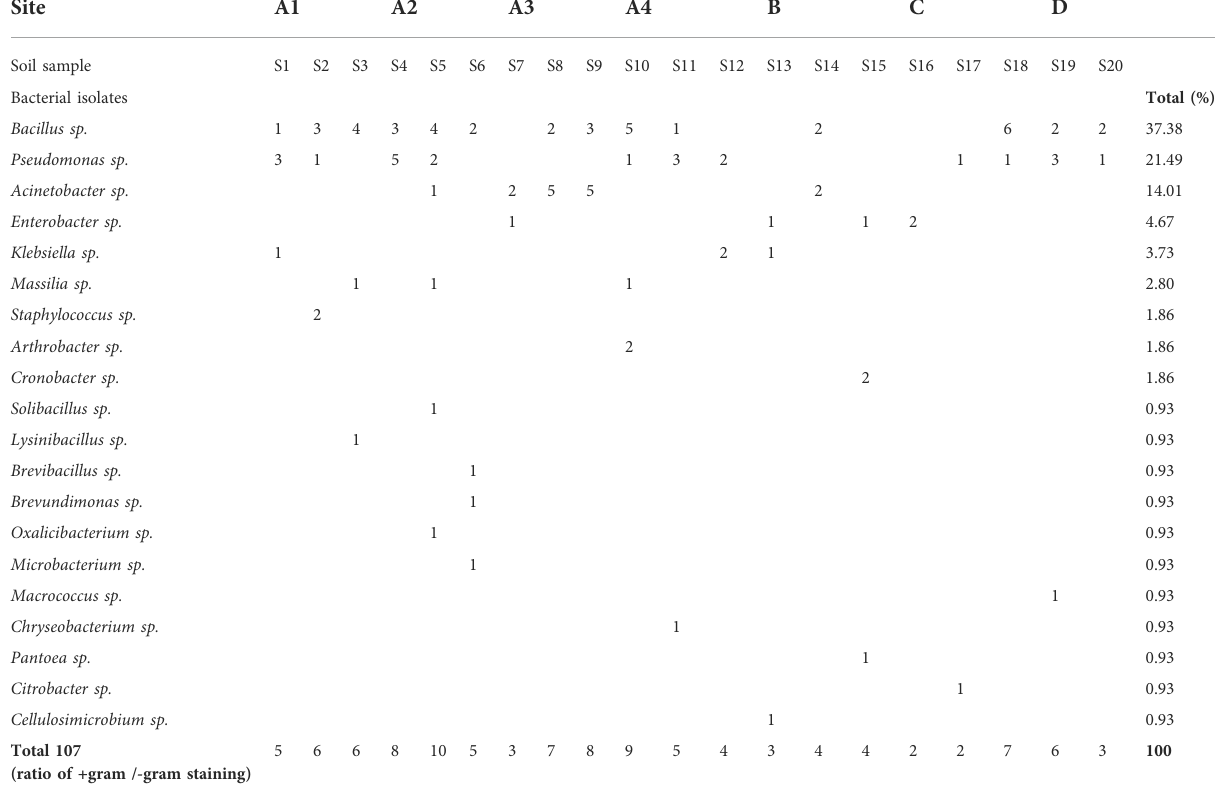
TABLE 2 Relative abundance of bacterial genera in each soil